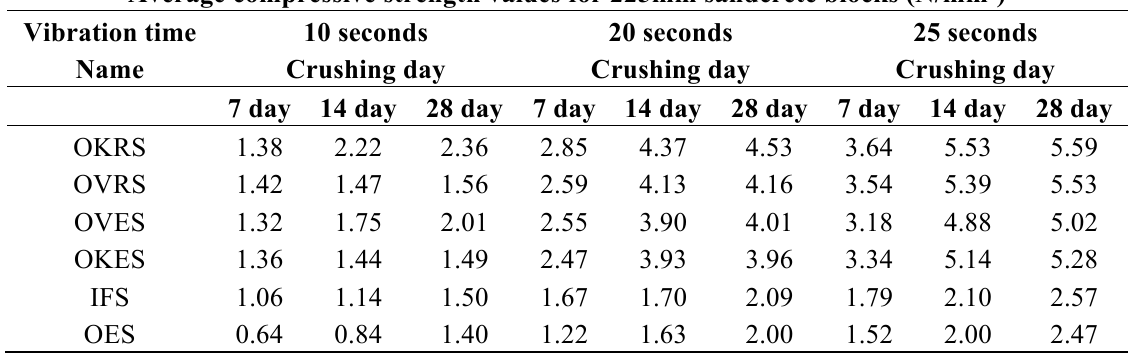
Table 9. Average compressive strength values for 225 mm sandcrete blocks at 10 seconds, 20 seconds and 25 seconds vibration time.